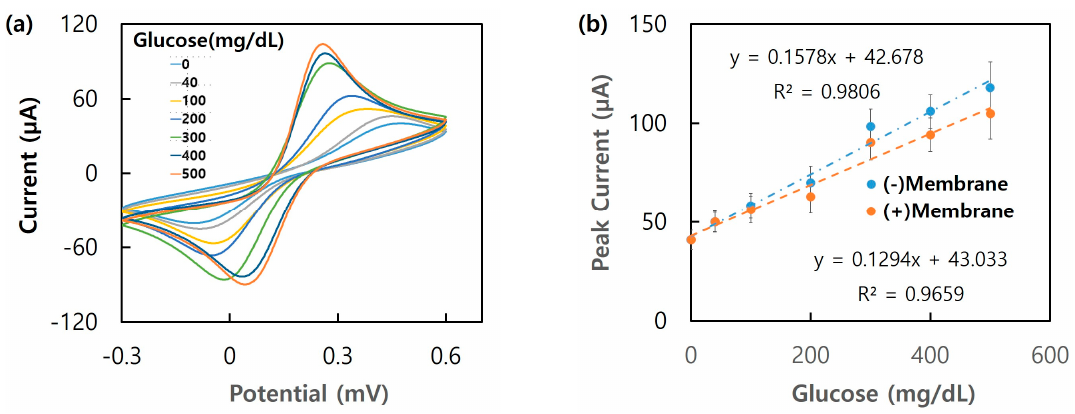
Figure 7. Electrochemical detection of glucose in artificial sweat using DA-modified electrode with asymmetric membrane. ( a ) Cyclic voltammograms and ( b ) peak currents obtained using glucose in the range of 0–500 mg/dL. 20 µ L of artificial sweat containing glucose was applied to the electrodes and CV measurements were carried out.